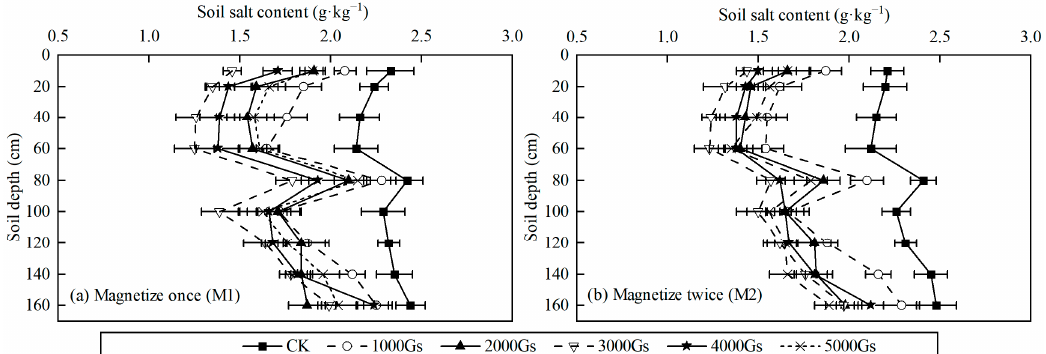
Figure 7. Vertical distribution of salinity content in jujube growth period under magnetized water irrigation.